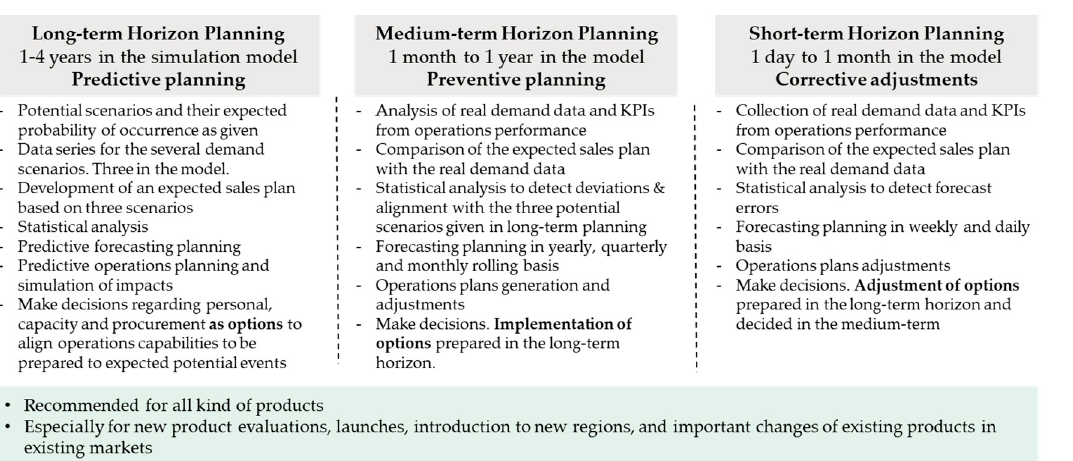
Figure 3. Sales and operations planning (S&OP) plan and management decisions based on potential scenarios (own elaboration).